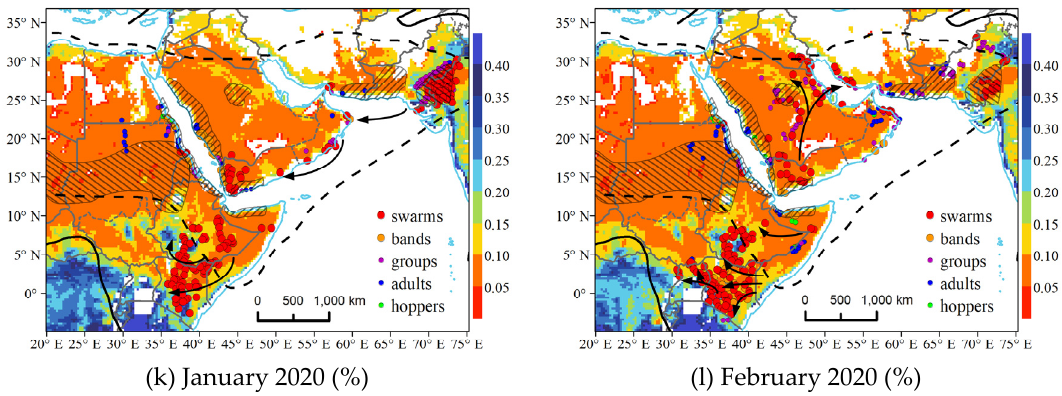
Figure 5. Soil moisture over part I of the study area during 2019–2020.